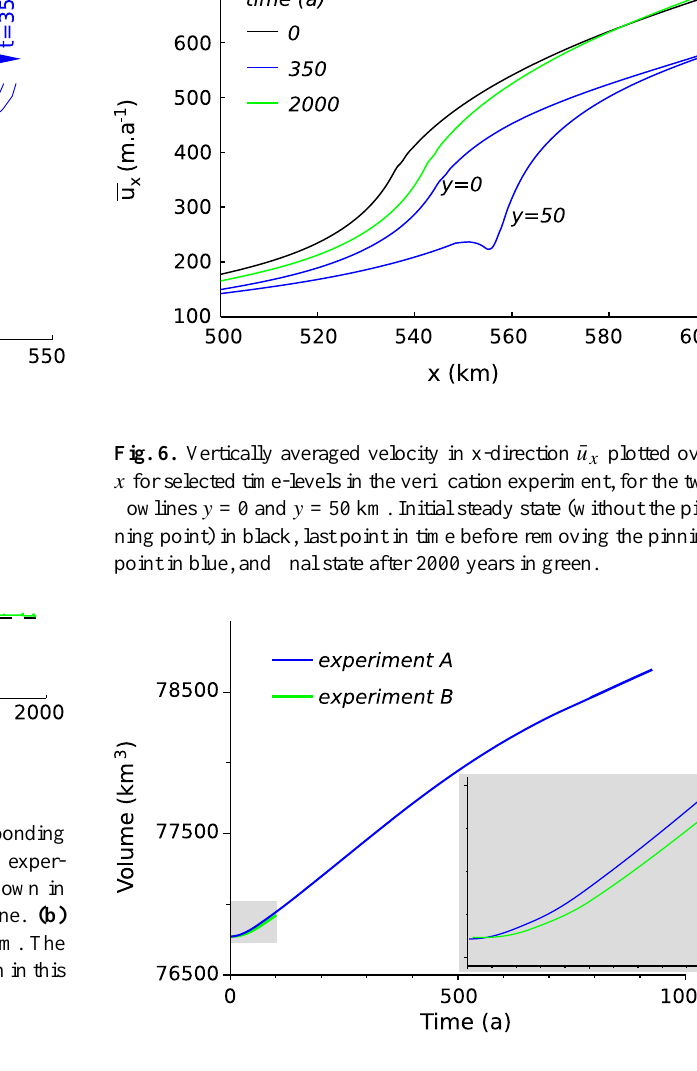
Fig. 7. Evolution of the ice volume over time for experiment A (blue curve), and experiment B (green curve). The inset is a zoom into the first 100